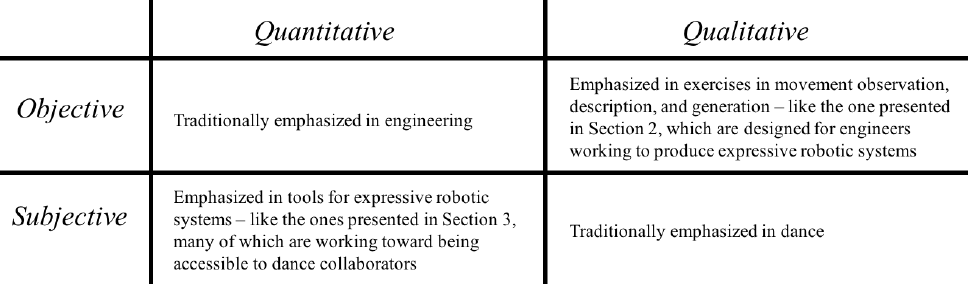
Figure 5. Qualitative and quantitative methods are needed to explain and design objective and subjective phenomena. This diagram frames how the methods and results presented here aid in this need, bringing balance to the upper right and lower left quadrant of the